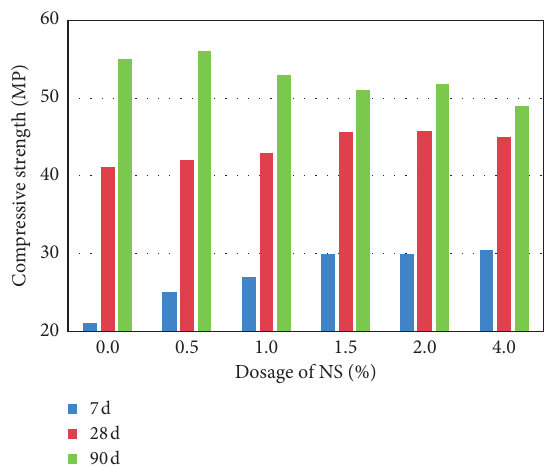
Figure 7: Effect of NS on compressive strength of the C-FA